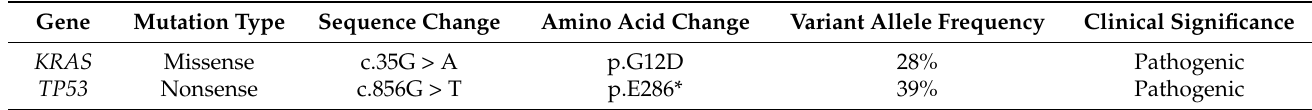
Figure 1. Pelvic magnetic resonance imaging and gross finding and scanning-view photomicrograph. A sagittal T2-weighted image revealed a 2.5-cm mass arising from the left upper vagina (green arrowheads). The mass extended into the extravaginal tissue. The cut section of the resected specimen displayed a poorly circumscribed, yellow-to-white, solid, rubbery tumor involving the subvaginal soft tissue (blue arrowheads). A photomicrograph matched the gross image showing an infiltrative tumor tissue destructively invading through the entire vaginal wall into the subvaginal soft tissue. Table 1. Targeted sequencing